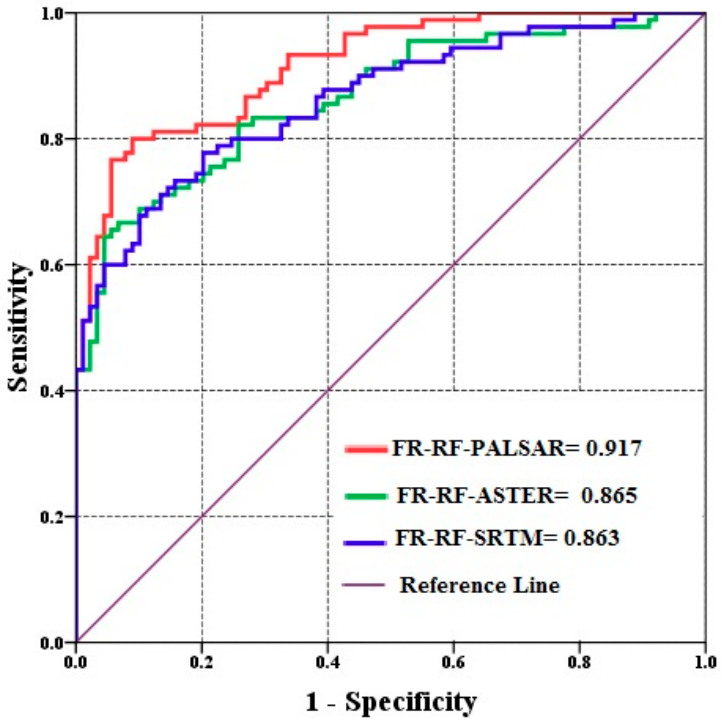
Figure 9. AUC values of FR–RF–PALSAR, FR–RF–ASTER and FR–RF–SRTM.